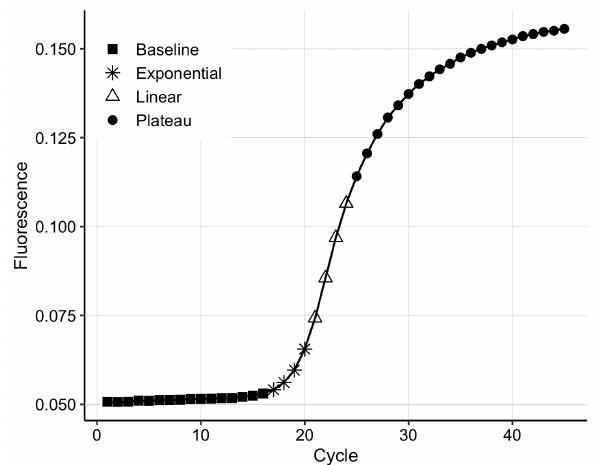
Figure 1. The four phases of the real-time polymerase chain reaction (qPCR) amplification curve.